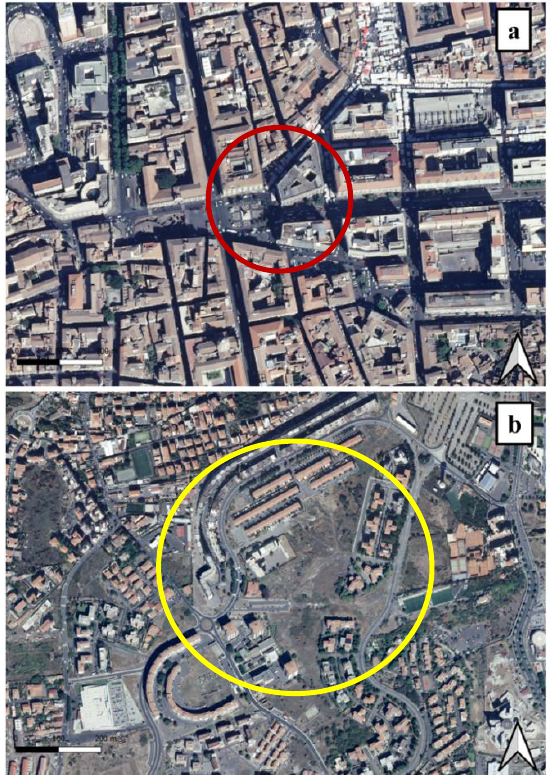
Figure 11. Location of Stesicoro square (red circle in ( a )) and San Nullo district (yellow circle in ( b )).